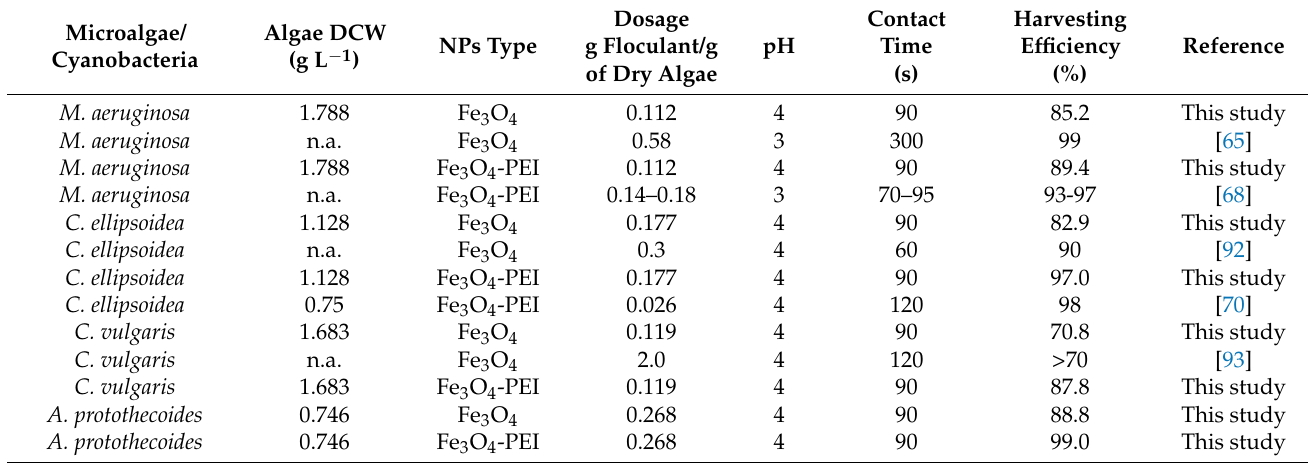
Table 2. Harvesting efficiencies of green algae and